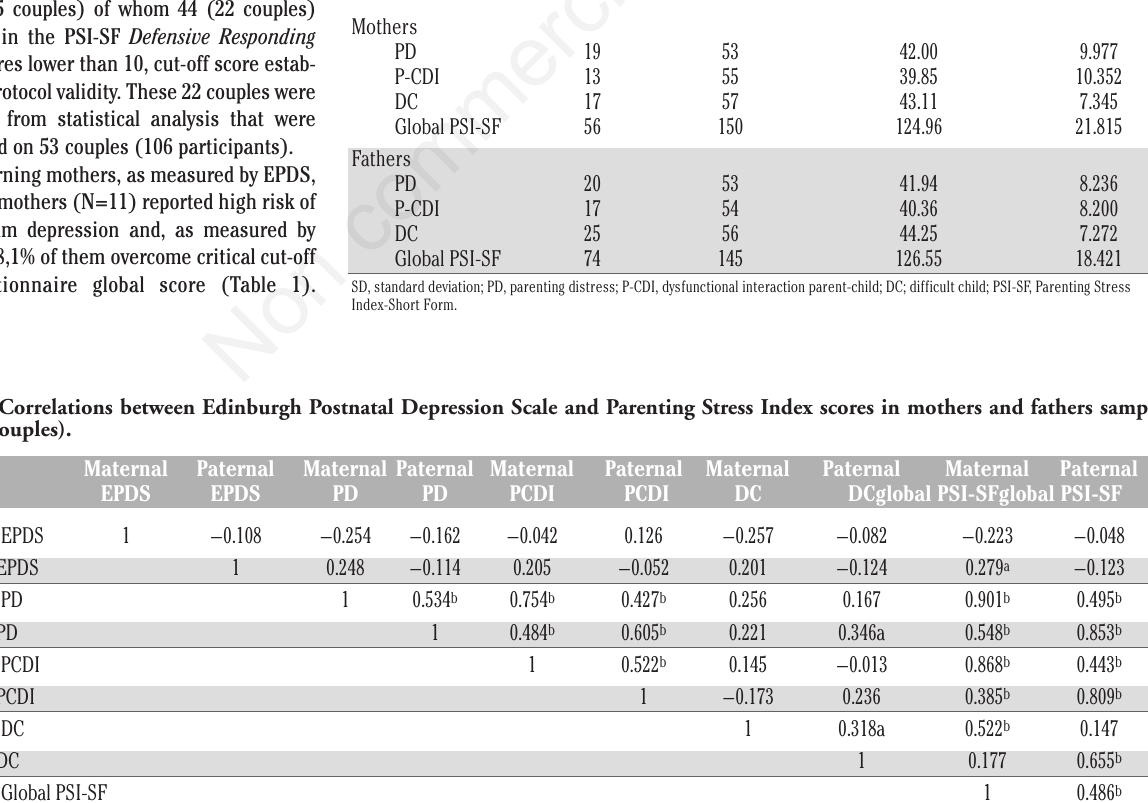
Table 2. Descriptive statistics on Parenting Stress Index-Short Form scores (N=53 cou- ples). Min.